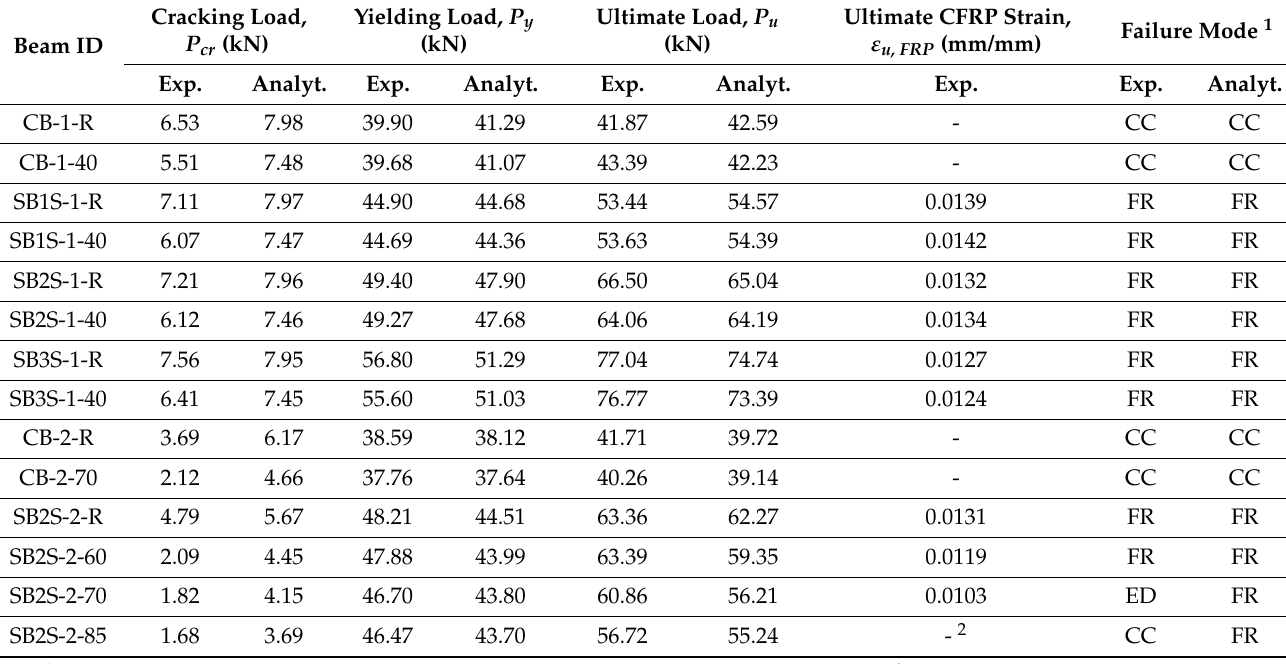
Table 3. Experimental results and analytical